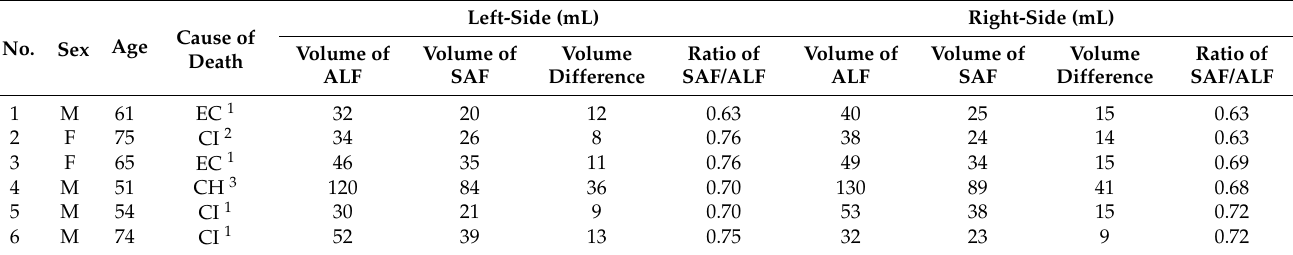
Figure 5. Photographs indicating course of the perforators of adductor longus from the perforating artery of femoral profound artery: ( A ) shows the direct view to the adductor longus, ( B ) with the adductor longus lifted outwards, ( C ) with the adductor longus lifted inwards (red triangle: femoral artery, black triangle: femoral profound artery, AL: adductor longus, red arrow: perforating artery, the branch of femoral profound artery, black arrow: muscular perforators of the adductor longus). Table 1. The details of the cadavers.